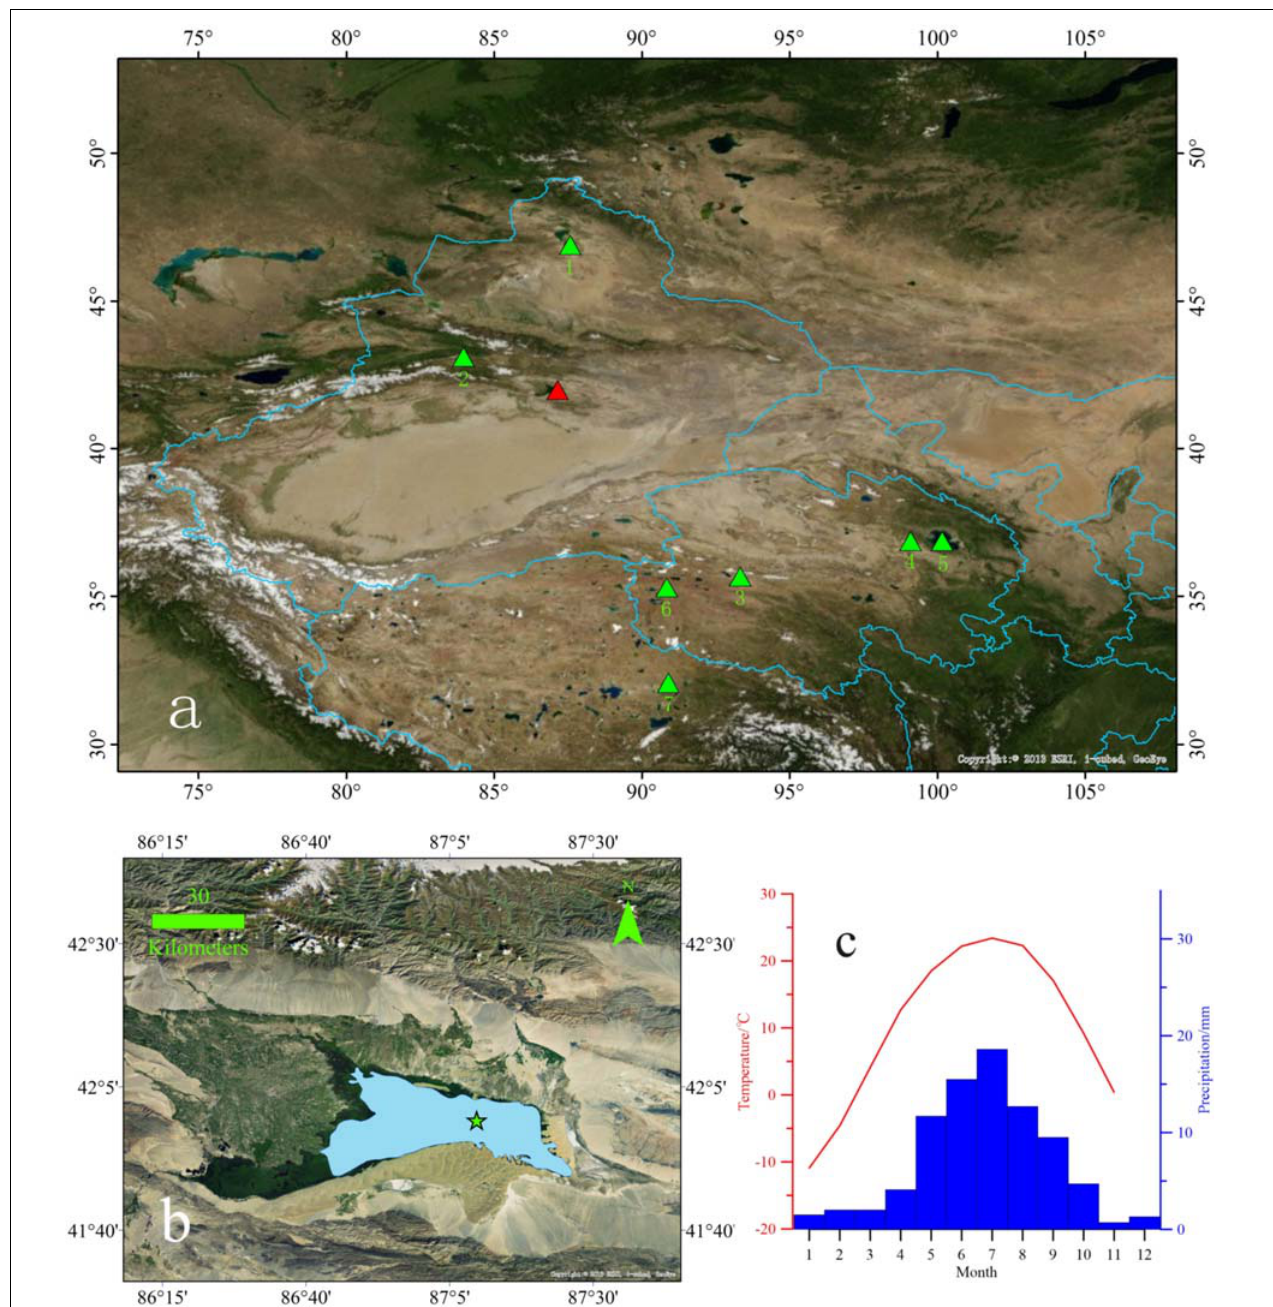
FIGURE 1 | Locations of Lake Bosten (red triangle in panel a ) and some lakes mentioned in the text (green triangles). 1, Lake Wulungu (Liu et al., 2008a); 2, Lake Harnur (Lan et al., 2018); 3, Lake Kusai (Liu et al., 2009); 4, Lake Chaka (Liu et al., 2008b); 5, Lake Qinghai (Shen et al., 2005); 6, Lake Donggi Cona (Mischke et al., 2013); 7, Lake Zigê Tangco (Herzschuh et al., 2006). (b) Shows the modern lake and the sampling site of this study (green star). (c) Shows the seasonal temperature and precipitation at Yanqi County ( ∼ 80 km to Lake Bosten; data from http://data.cma.cn/data/weatherBk.html;